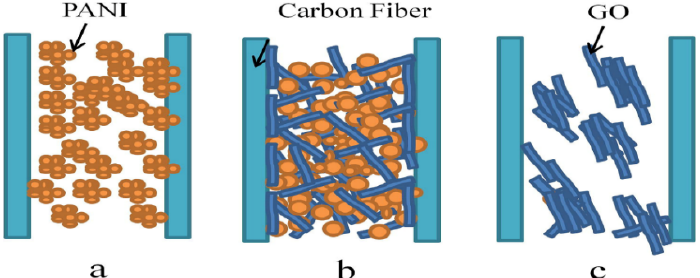
Figure 9. Representative dispersion of matrix: ( a ) random distribution of polyaniline (PANI), ( b ) enhanced dispersion of hybrid fillers due to the electrostatic interaction, ( c ) poor dispersion of GO due to the large particles’ agglomeration. Reproduced with permission from [105]. Copyright Elsevier, 2016.